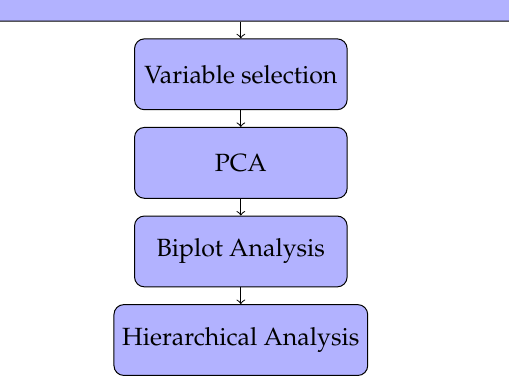
Figure 1. Research flow